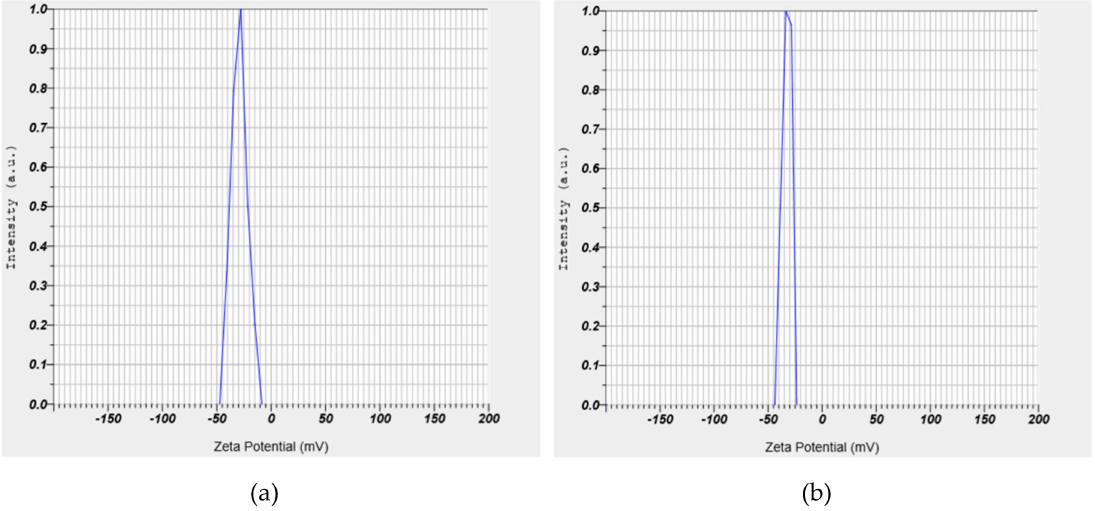
Figure 9. Zeta potential measurements for ( a ) SiO 2 and ( b ) alpha olefin sulfonate (AOS) + SiO 2